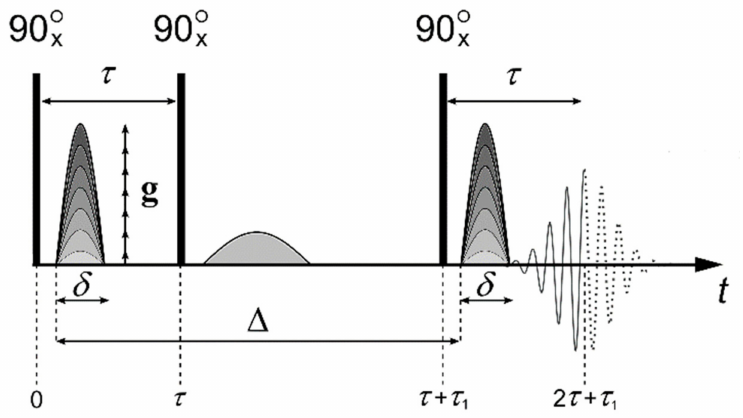
Figure A1. Stimulated echo pulse sequence with the magnetic field gradient pulses. Here, τ is the time interval between the first and second RF pulses, τ 1 is the time interval between the second and the third ones, ∆ is the interval between the gradient pulses, δ is duration of the equivalent rectangular magnetic field gradient pulses, g is the amplitude of the magnetic field gradient